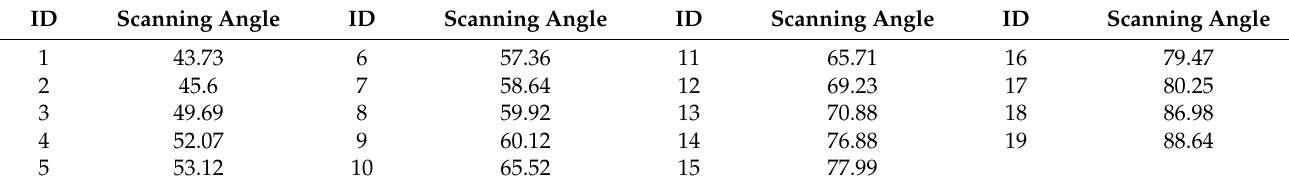
Table 1. Parameter setting for UAV data acquisition. Table 2. Scanning angle of each route in the real